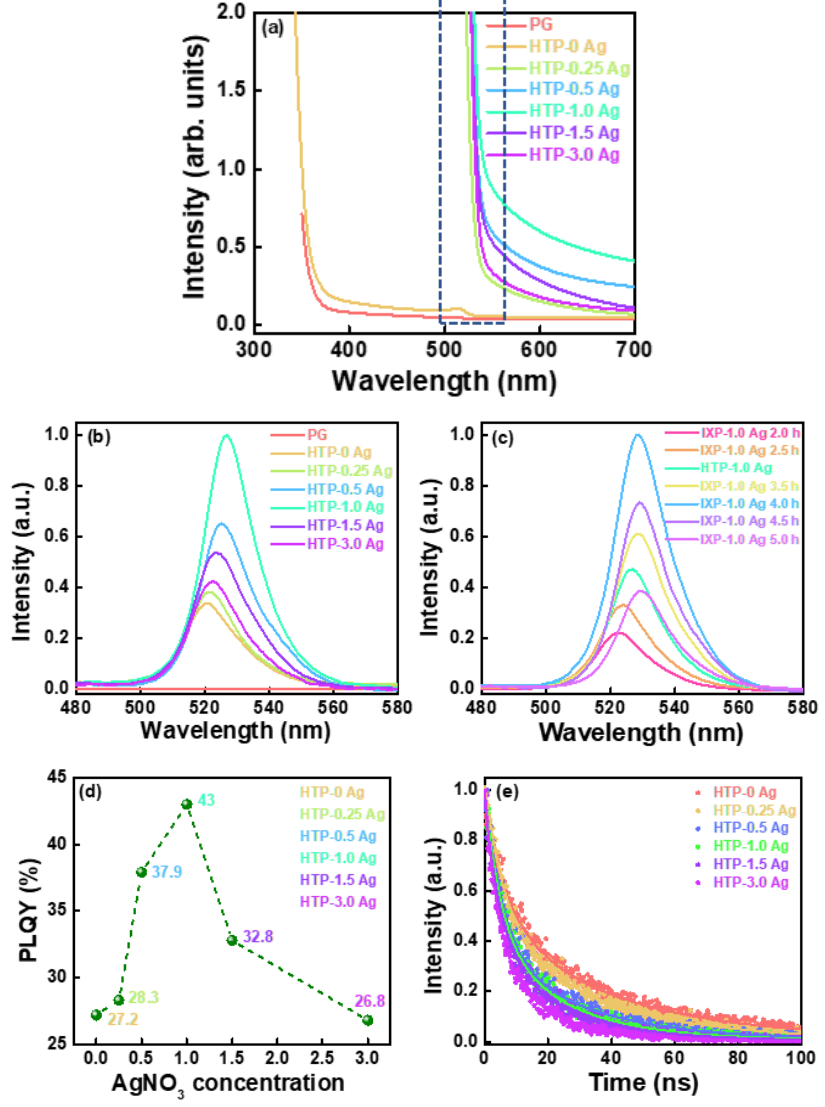
Figure 8. ( a ) Absorption, ( b , c ) emission spectra, ( d ) PLQYs and ( e ) fluorescence decay curves of CsPbBr 3 QD-doped glasses containing Ag NPs.